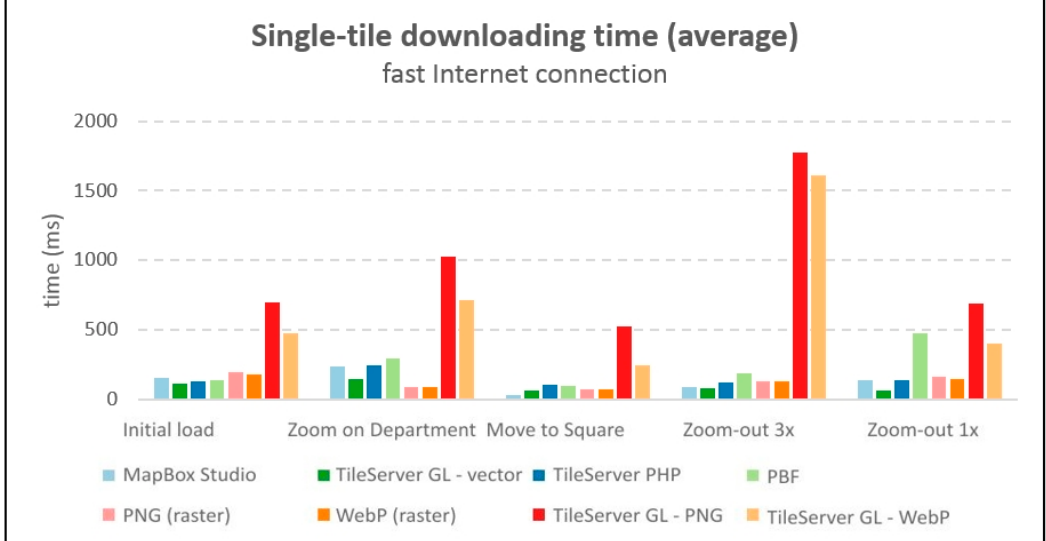
Figure 7. Results of single-tile downloading times (fast Internet